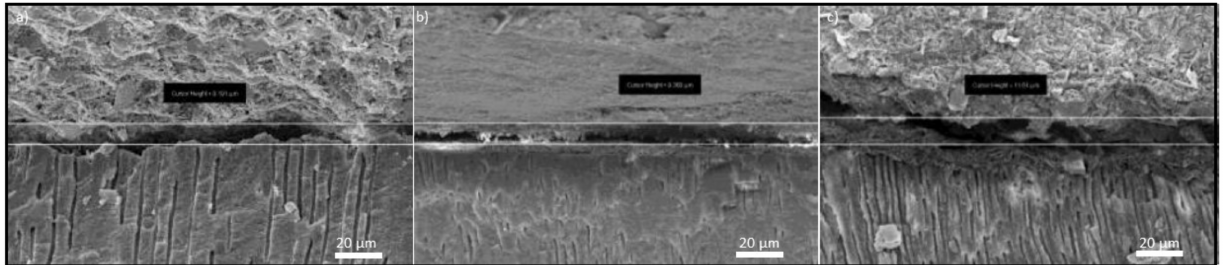
Figure 19. Leaks on the border of the root canal sealant and dentin after obturation with resilon as a cold filling material, with measurements of the width of the gaps equal to (SEM): ( a ) 9.191 µ m; ( b ) 9.368 µ m; ( c ) 11.64 µ